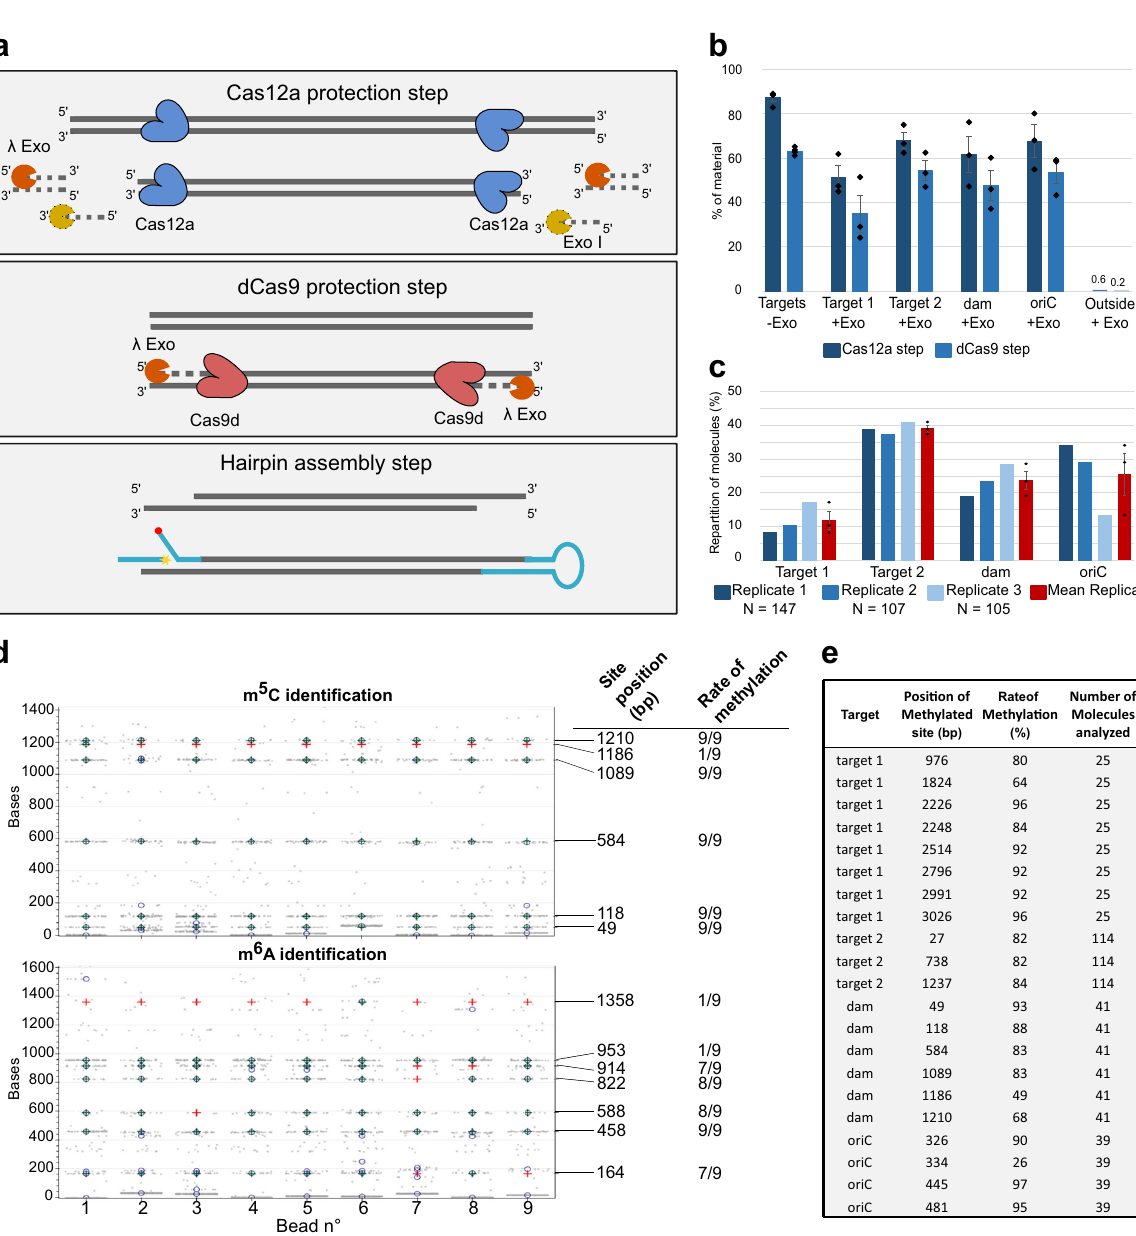
Fig. 5 Enrichment of speci fi c genomic regions using a CRISPR-based method. a The enrichment protocol is divided into three major steps: (1) Flanking the region of interest with two Cas12a complexes, followed by digestion of all remaining genomic DNA with exonucleases. (2) Second, the generation of 3 ’ ssDNA overhangs at each end of the fragment used to assemble the hairpins are created using the dead Cas9, followed by lambda exonuclease digestion. (3) Finally, this fragment is used to assemble the hairpin structure required for our platform. A more detailed protocol is available in Supplementary Fig. 8. b qPCR of enrichment of four E. coli targets. A control excluding the exonucleases was included (to account for puri fi cation loss) and a positive control for digestion was performed by quantifying off-target DNA. Protection was measured for each target after the Cas12a (dark blue) and dCas9 (light blue) steps. Bars represent the average protected material from three biological replicates + s.e.m, n = 3. c Repartition of target molecules analyzed on the MT platform from three biological replicates (shades of blue) and their average (red bars). d Detection of m 5 C and m 6 A on the same enriched dam molecules (each column represents a single molecule, and in each panel, the same column corresponds to the same bead). Gray points indicate detected binding events and the expected modi fi cation positions are indicated on the right axis. Blue crosses indicate detected blockages corresponding to the modi fi cation and red crosses indicate expected positions where methylation was not detected. e Analysis of m 5 C methylation of all the isolated E. coli fragments for all three biological replicates. The CCwGG site positions within the hairpins are indicated, as well as their rate of